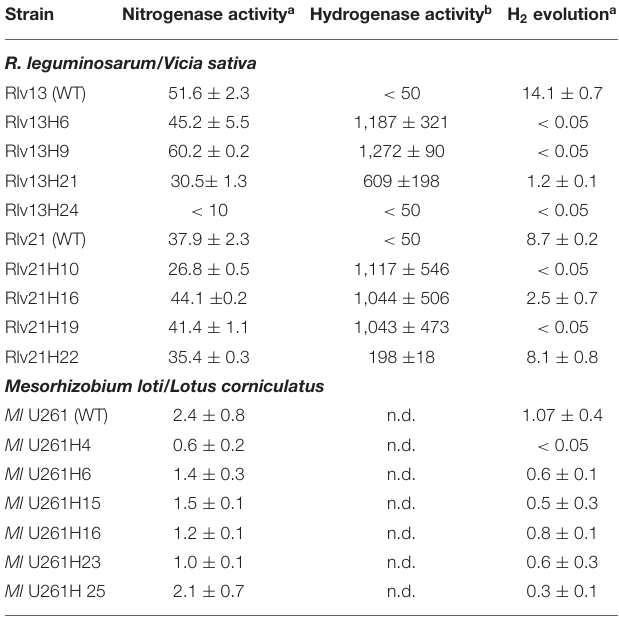
TABLE 2 | Effect of the introduction of hup genes on symbiotic performance of Rlv strains in association with V. sativa plants. Strain a